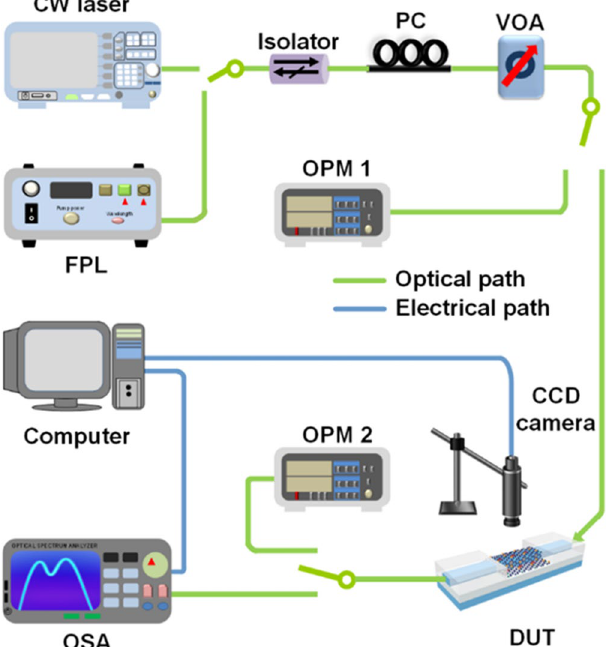
Figure 2. Experimental setup for measuring loss and SPM of GO-coated SOI nanowires. CW laser: continuous-wave laser. FPL: fiber pulsed laser. PC: polarization controller. VOA: variable optical attenuator. OPM: optical power meter. DUT: device under test. CCD: charged-coupled device. OSA: optical spectrum